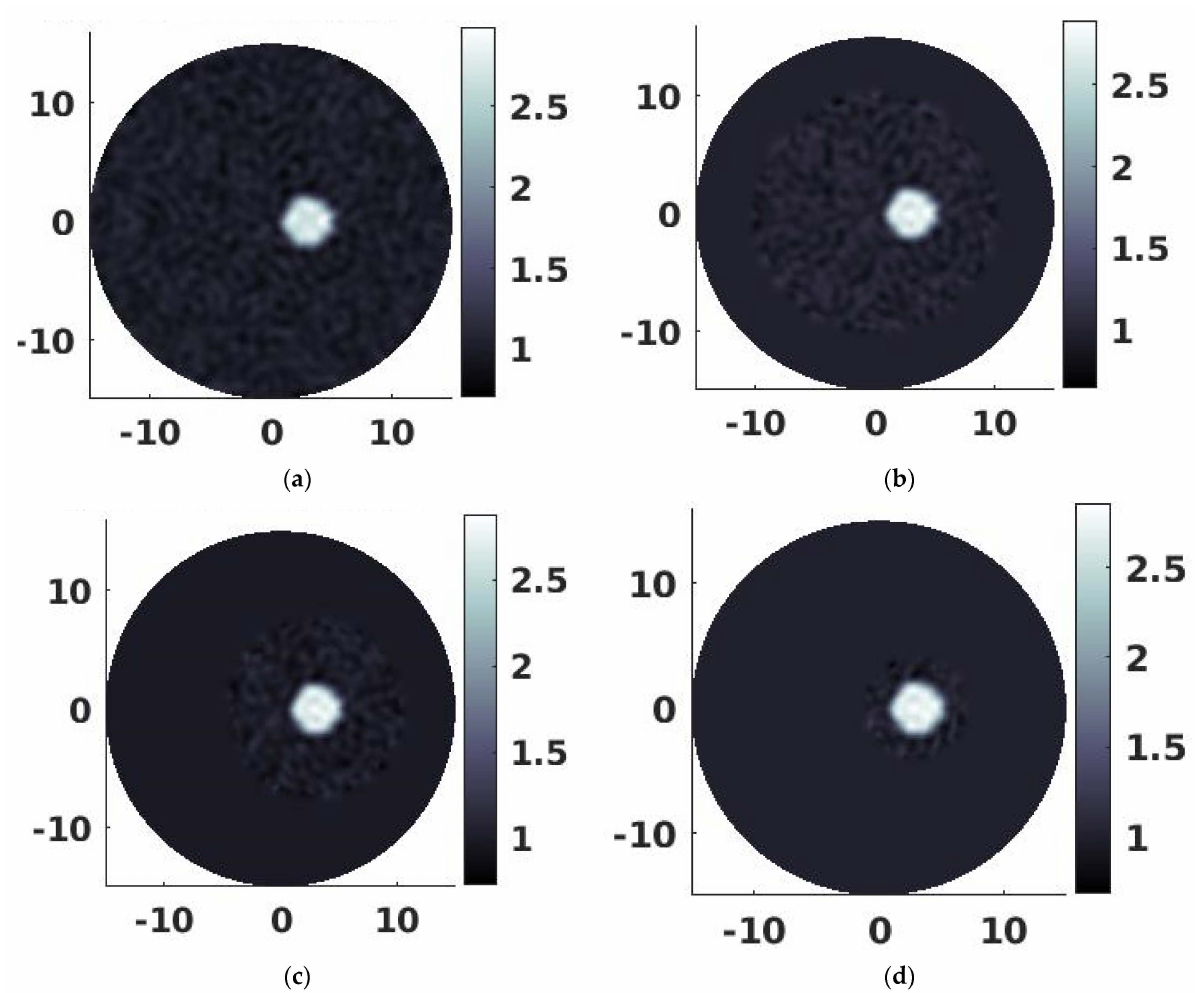
Figure 1. Reconstructed photoacoustic images of the simulated target by using full zone-based FE-PAT algorithm ( a ) and localized FE-PAT algorithm in a ROI with radii of 10.0 mm ( b ), 7.5 mm ( c ) and 4.0 mm ( d